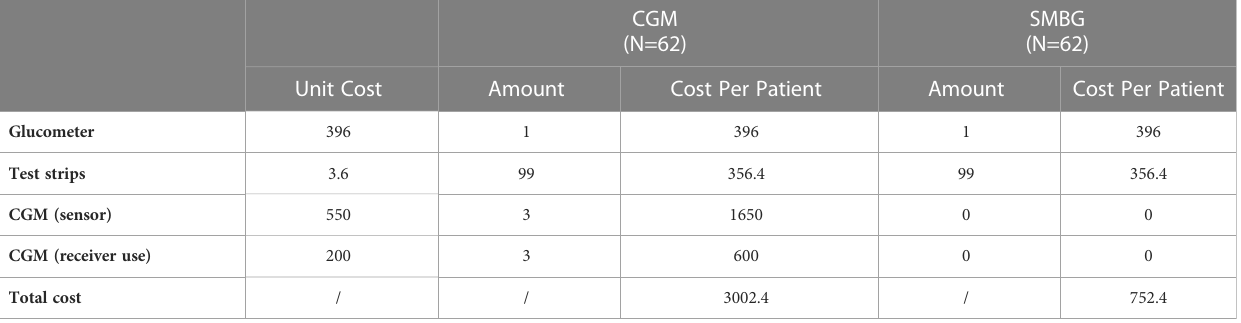
TABLE 5 Cost of Glucose Monitoring during Pregnancy.